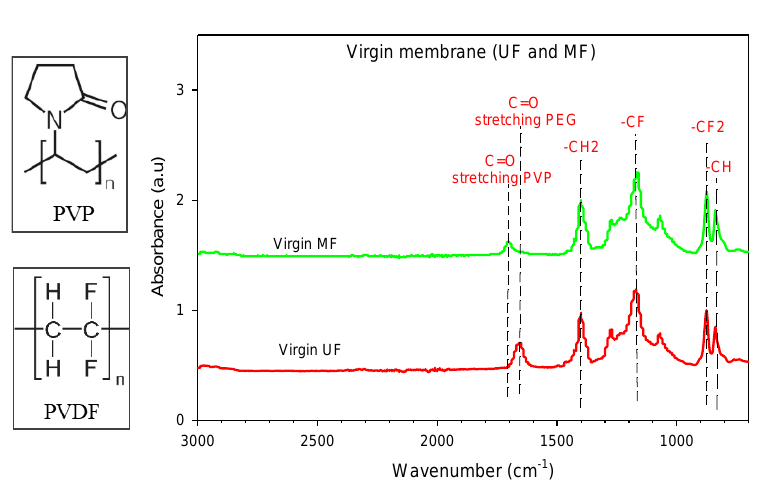
Figure A1. FTIR spectra of virgin MF and UF membranes.